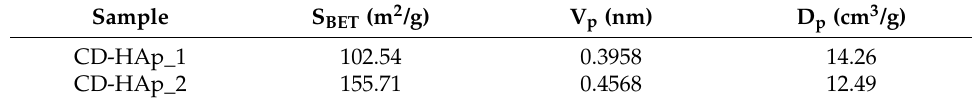
Table 1. Parameters of nitrogen adsorption/desorption isotherms of CD-HAp_1 and CD-HAp_2 nanocomposites.